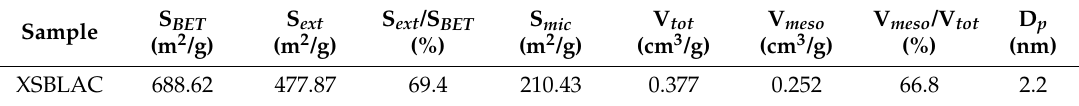
Table 1. Pore structure parameters of the sample studied in this work.